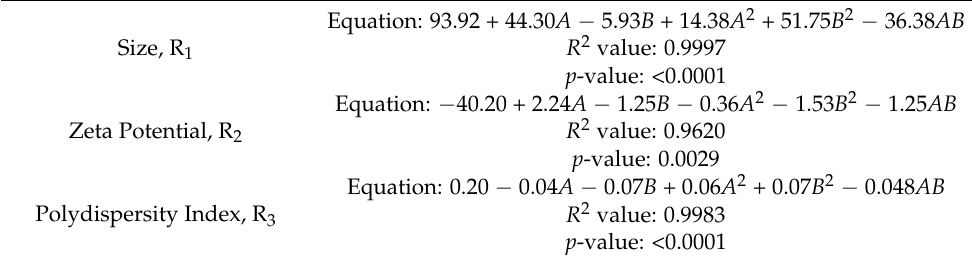
Table 1. Equations, regression coefficients and probability values for the final reduced model.